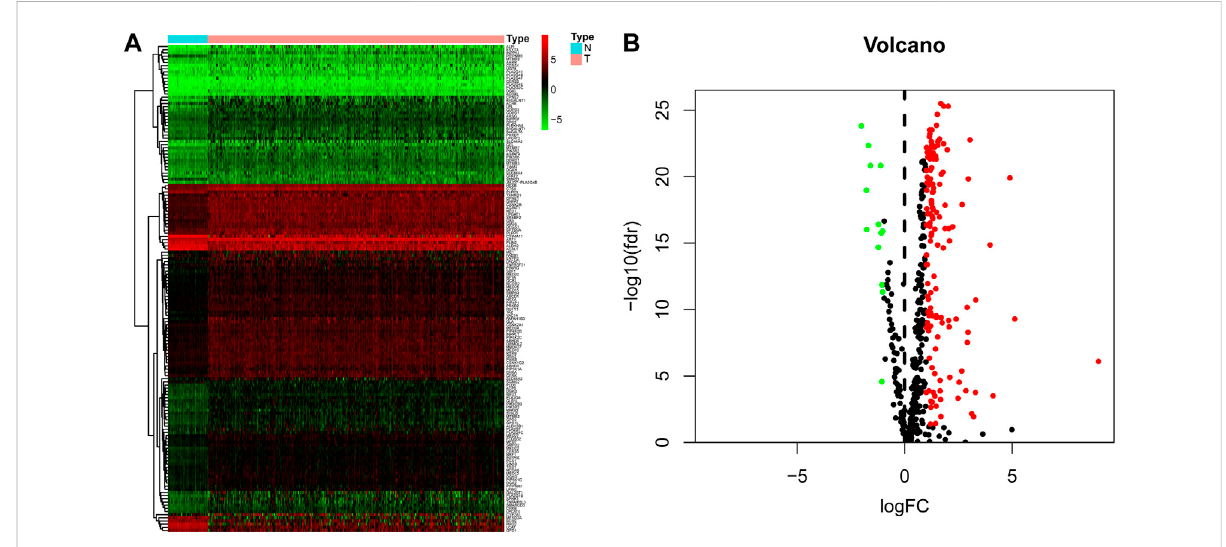
FIGURE 1 Differentially expressed lipid metabolism-associated genes in hepatocellular carcinoma (HCC) patients. Heatmap (A) and volcano plot (B) demonstrate differentially expressed lipid metabolism-associated genes between HCC and non-tumor tissues. Red and green tones represent up- regulated and down-regulated expression levels,